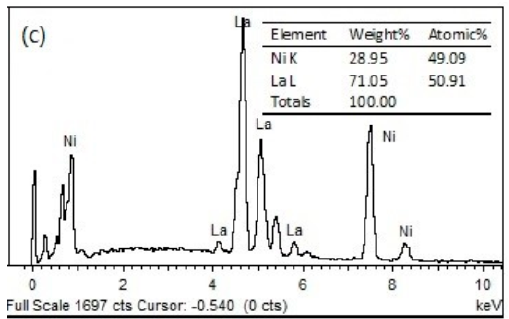
Figure 3. EDS spectra of phases in Ni 49.3 Ti 50 La 0.7 alloy: ( a ) Ti 2 Ni; ( b ) TiNi; ( c ) LaNi.